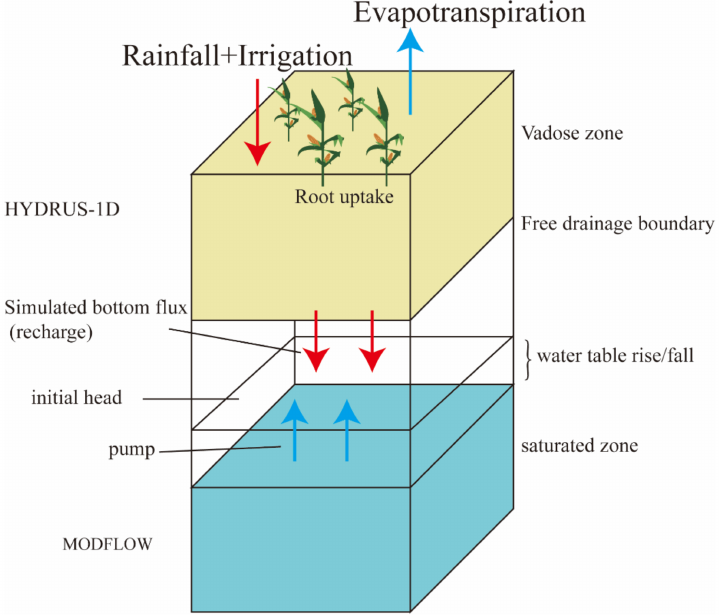
Figure 2. Conceptual framework for simulating water transport in vadose zones and aquifers using HYDRUS-1D and MODFLOW models.